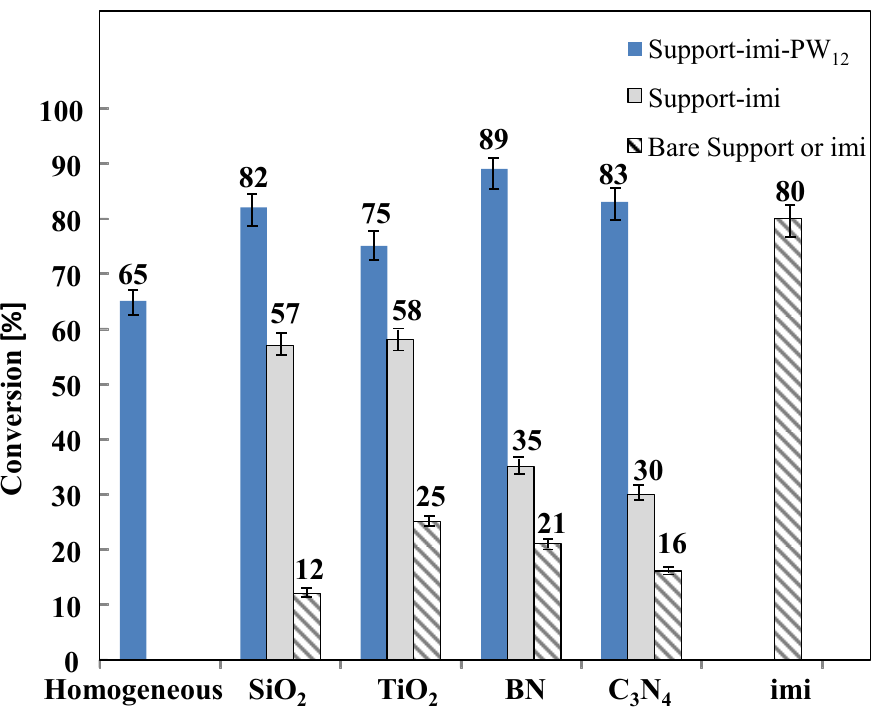
Figure 8. Conversion of fructose for catalytic reactions carried out in aqueous medium at 165 ◦ C for 3 h in the presence of the different catalysts. Initial substrate concentration 1 M at natural